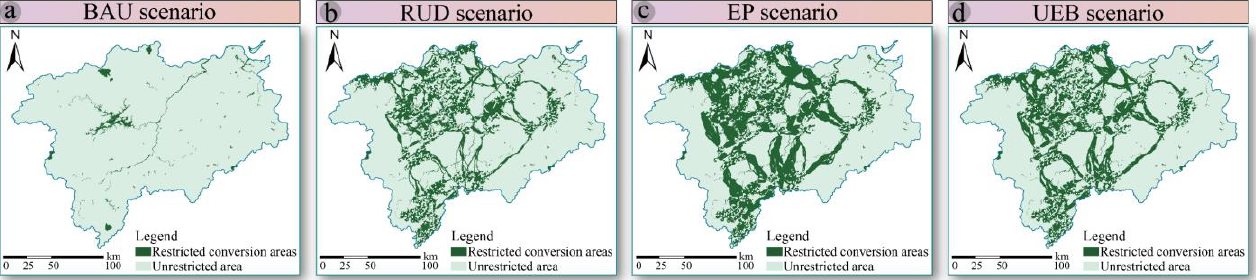
Figure 6. Ecologically restricted areas in each scenario.